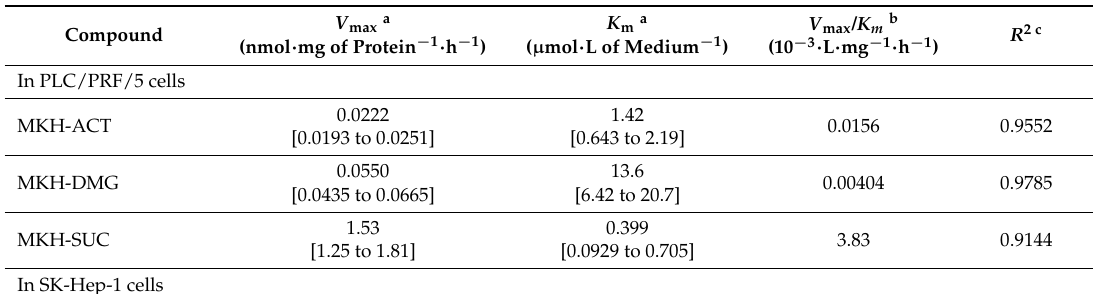
Figure 4. Kinetic plots for the regeneration of MKH-ester derivatives to MKH in S9 fractions of PLC/PRF/5 or SK-Hep-1 cells. ( A ) MKH acetate (MKH-ACT); ( B ) MKH dimethylglycinate (MKH-DMG); and ( C ) MKH succinate (MKH-SUC). Each point represents the mean ± SD from duplicate experiments. Table 2. Kinetic parameters for the regeneration of MKH-ester derivatives to MKH in S9 fractions of PLC/PRF/5 and SK-Hep-1